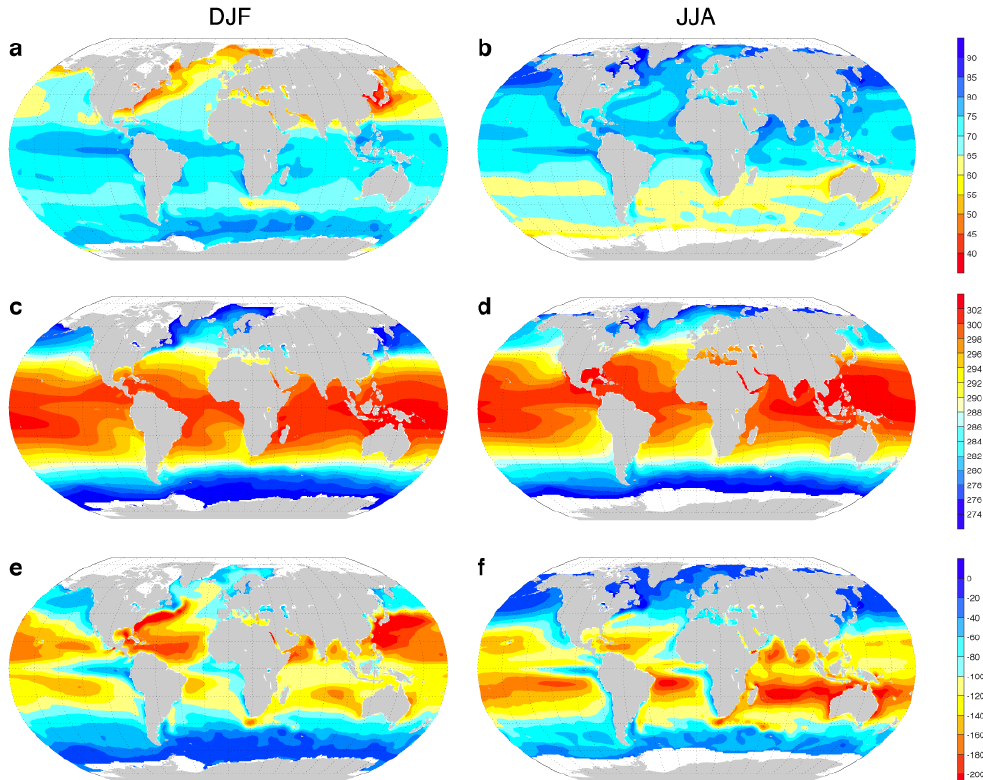
Fig. 3. Seasonal means of relative humidity over the ocean for DJF (December-January-February) (a) and JJA (June-July-August) (b) , sea surface temperature for DJF (c) and JJA (d) , as well as surface LHF for DJF (e) and JJA (f) . The means of both RH and SST are weighted averages, using the local LHF as a weight. Regions with sea ice in the seasonal mean are masked in